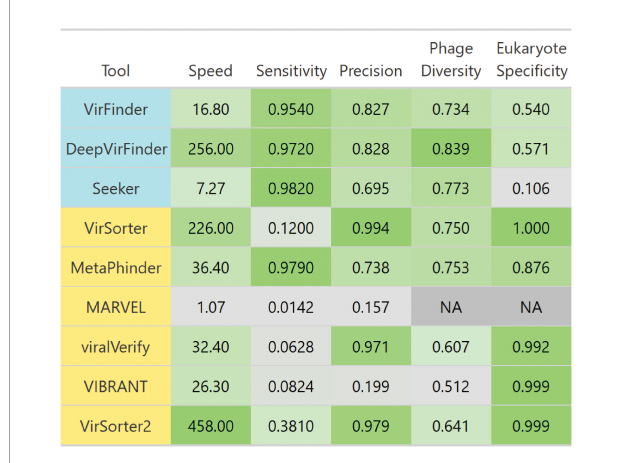
FIGURE10 Breakdown of each evaluated tool’s performance. Tools are colored such that homology-based methods are yellow and sequence-based tools are blue. Colors are scaled from the minimum to maximum value in each column. Scales are linear, except for speed which is scaled to log 10 of speed. Speed is the average number of genome contigs from the simulated metagenome set classified per second. Sensitivity and precision are averages from classifying the simulated metagenomes set. Diverse phages is the average ratio of sensitivity on non-caudoviral phages vs. caudoviral phages. Eukaryote specificity is the average specificity when classifying eukaryotic genome